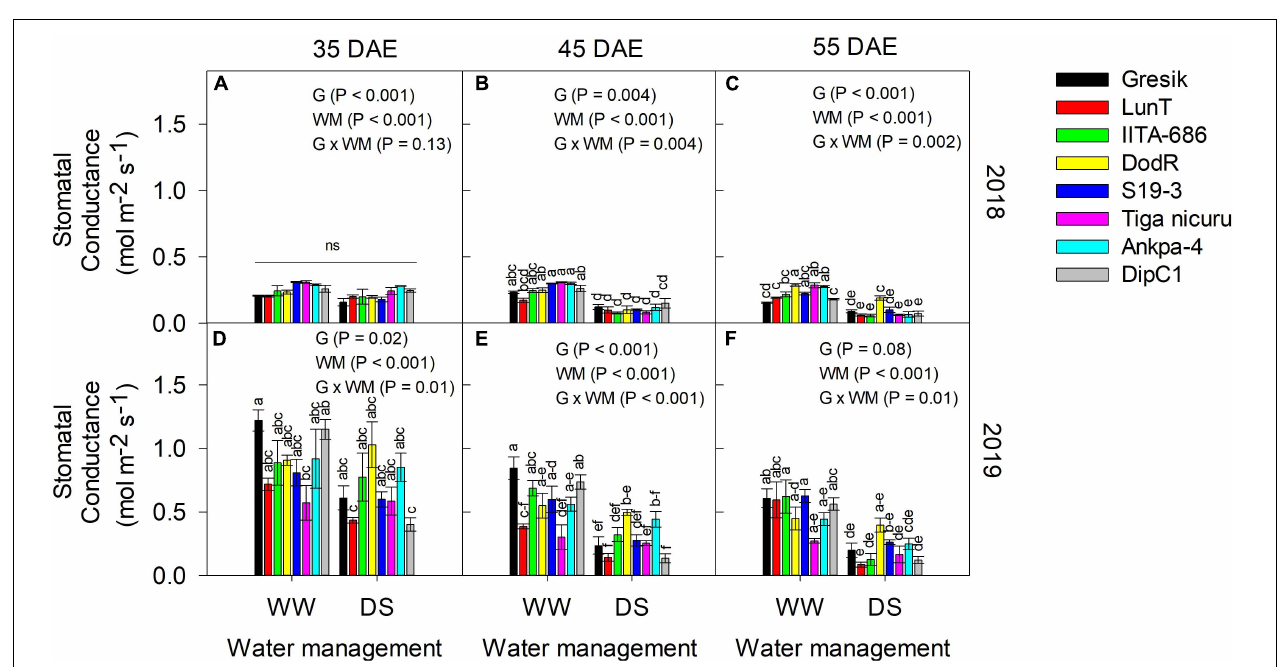
FIGURE 8 | Soil volumetric water content measured in the soil-filled PVC columns under a rainout shelter at three time points (35, 45, and 55 DAE) in 2019. Measurements are of eight bambara groundnut genotypes grown under WW (A–C) and DS (D–F) treatments. Mean ± SE values ( n = 3) are shown. Significant differences as follows: * p < 0.05, ** p < 0.01, and *** p < 0.001; and ns, not significant, amongst individual genotypes.